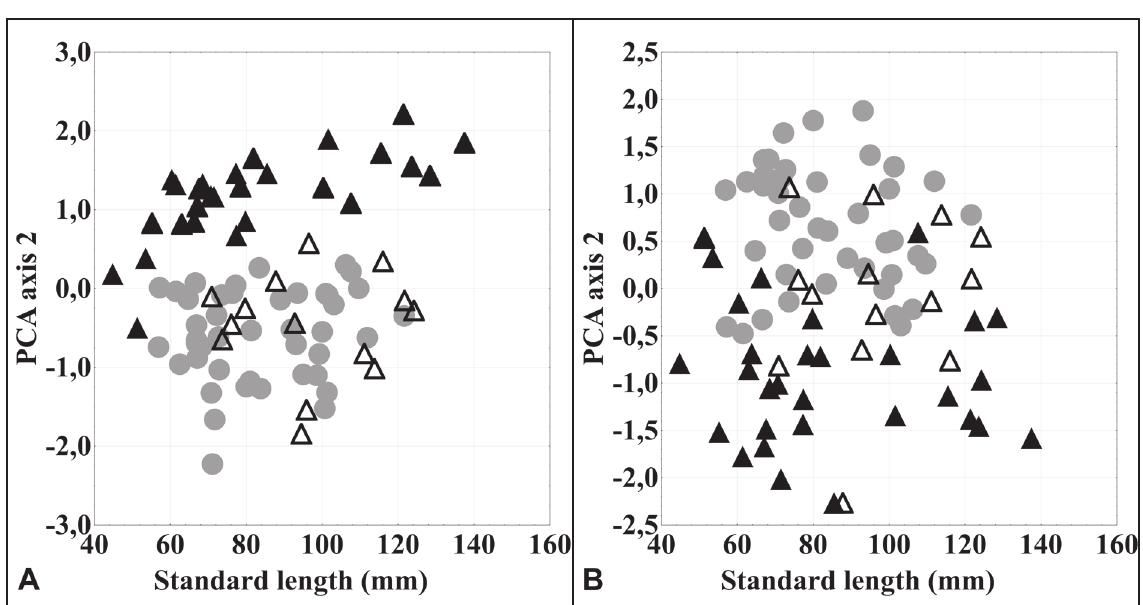
Fig. 3. Plots of the scores on the second axis of a PCA on the log-transformed measurements of Lake Victoria basin specimens against standard length, (A) including and (B) excluding lower pharyngeal bone measurements. Lakes Victoria and Kioga (∆); Lakes Edward-George-Kayanza-Nabugabo- Nakavali-Semliki (▲) ; Akagera basin (●).